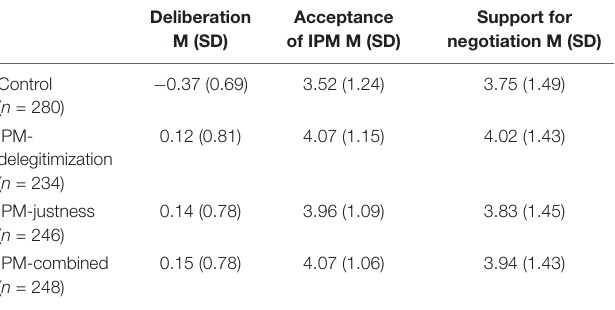
TABLE 6 | Descriptive statistics for dependent variables across conditions in Study